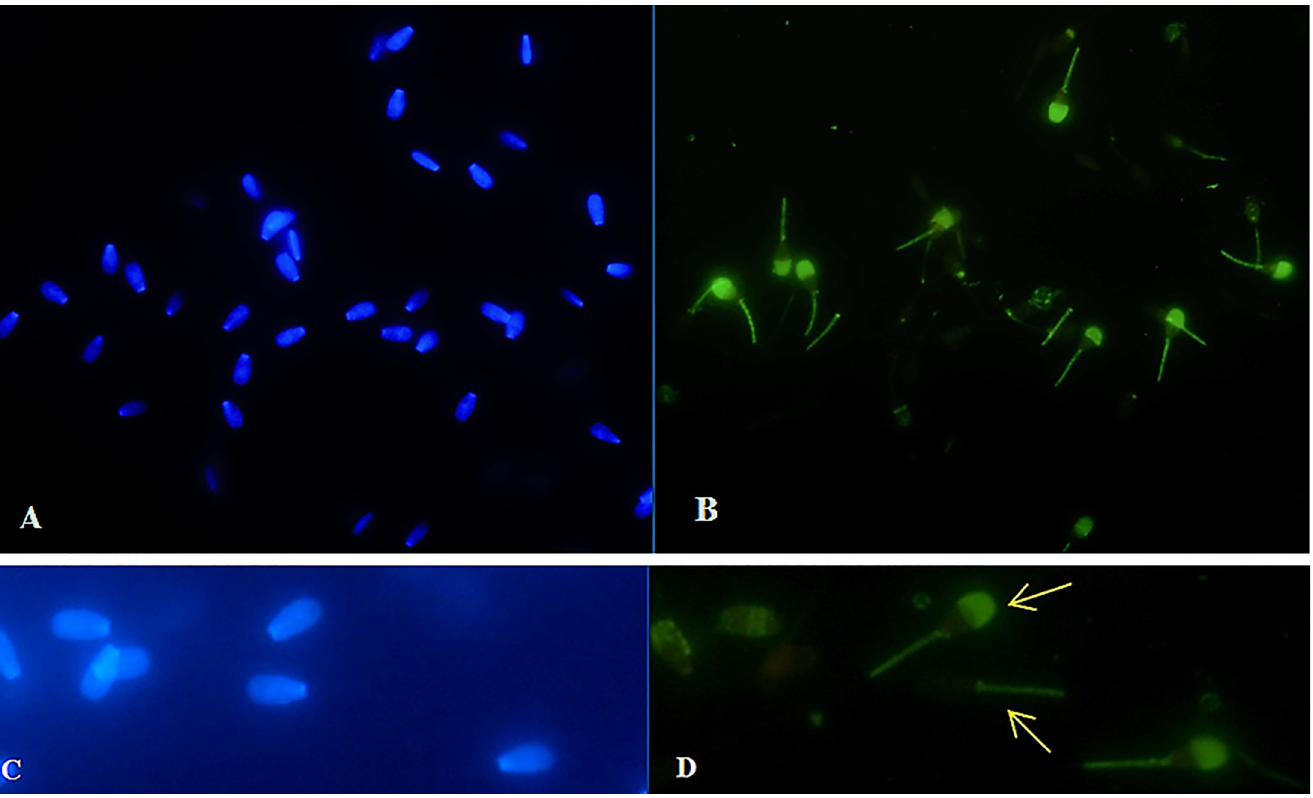
Fig 4. In vitro culture of spermatozoa with 500 μ M of FeSO 4 .7H 2 O after Time 6 h. Blue-stained (DAPI positive) chromatin of spermatozoa heads (A, C). Detection of apoptosis in spermatozoa (green staining) (B). Annexin V fluorescence reaction was detected in the mitochondrial segment and head (acrosomal part) of bovine spermatozoa (D; arrow) (400x